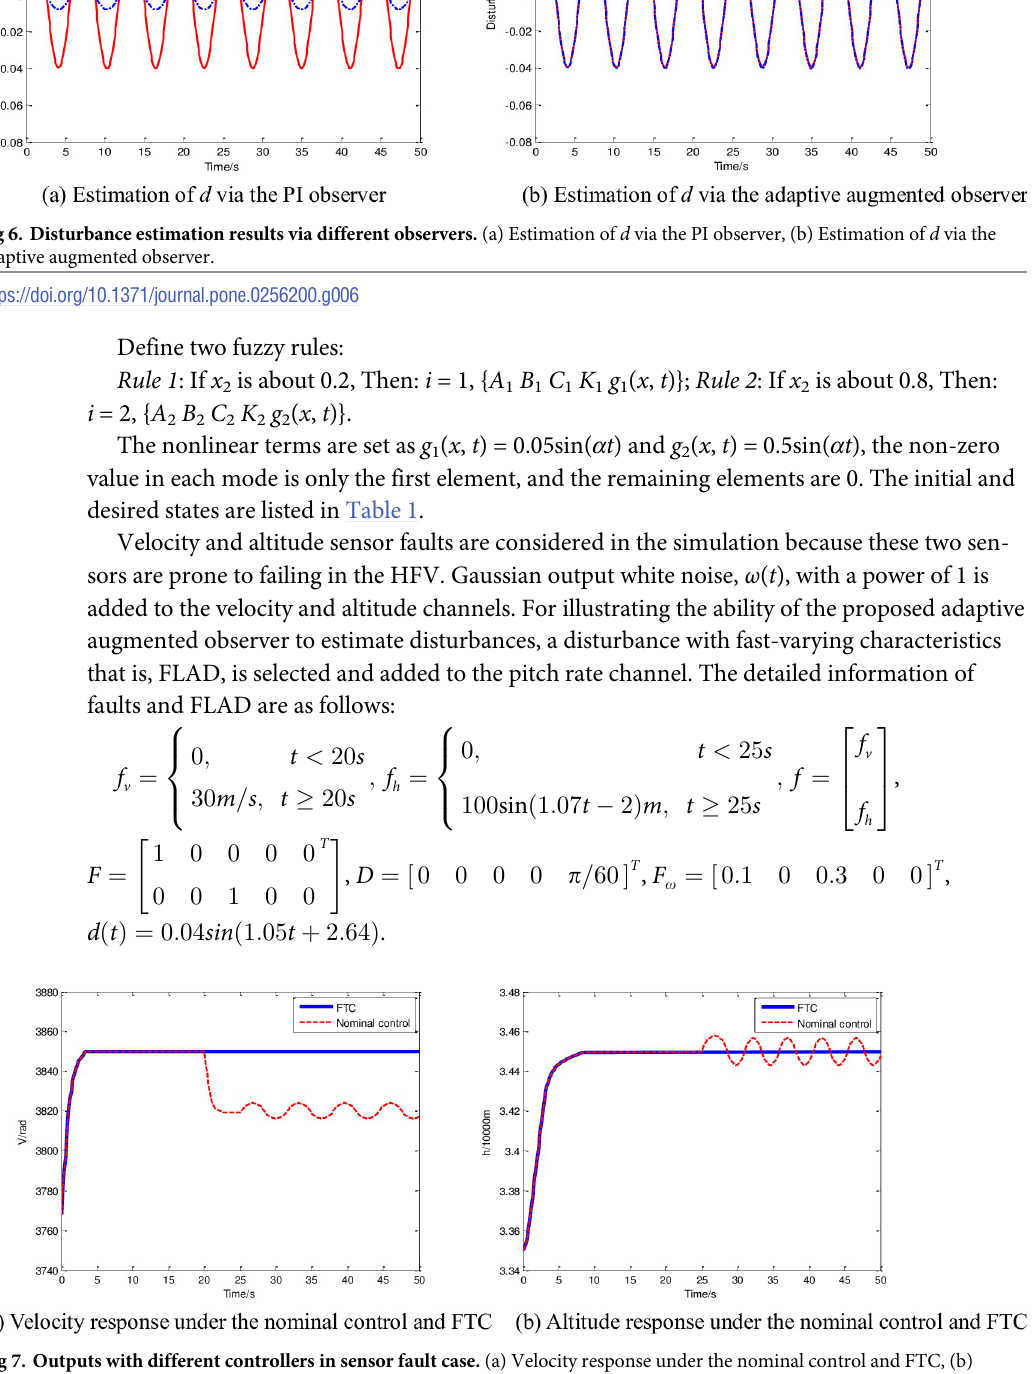
Fig 7. Outputs with different controllers in sensor fault case. (a) Velocity response under the nominal control and FTC, (b) Altitude response under the nominal control and FTC.